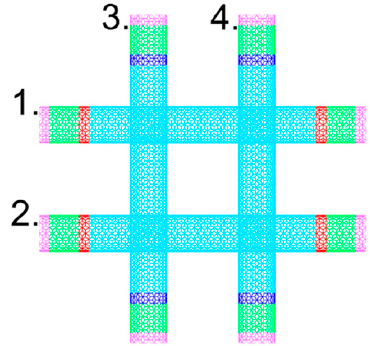
Figure 5. The calculation model 3 for the contact conductance of the double thermal contacts.